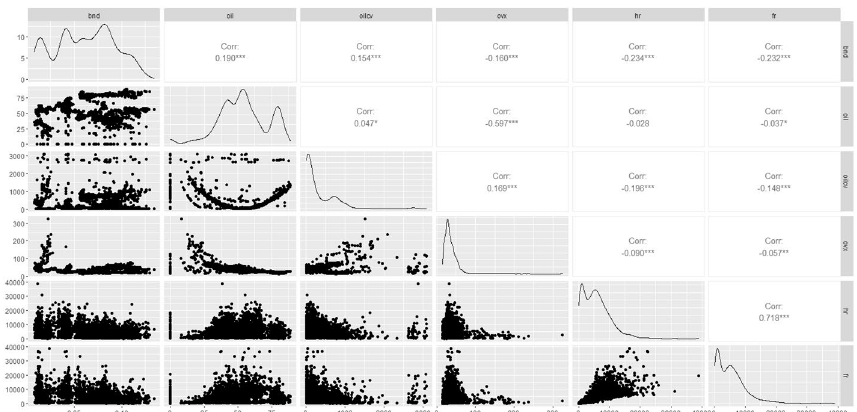
Fig. 1 Scatterplot matrices, Pearson correlation coefficients and variables